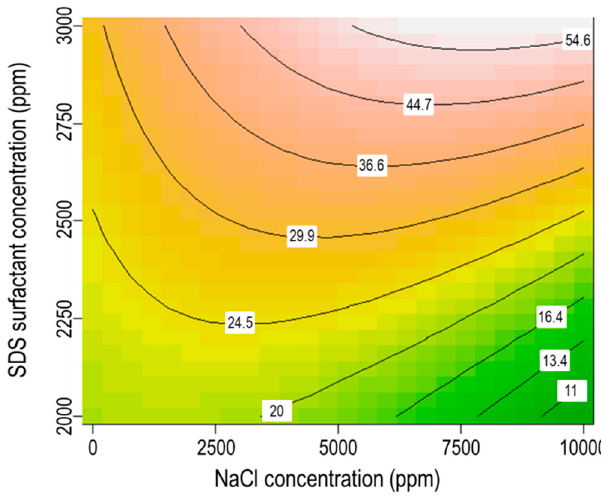
Figure 9. Interaction between SDS surfactant concentration and salinity at XG polymer concentration = 2500 (ppm) and stirring rate = 7000 (rpm).